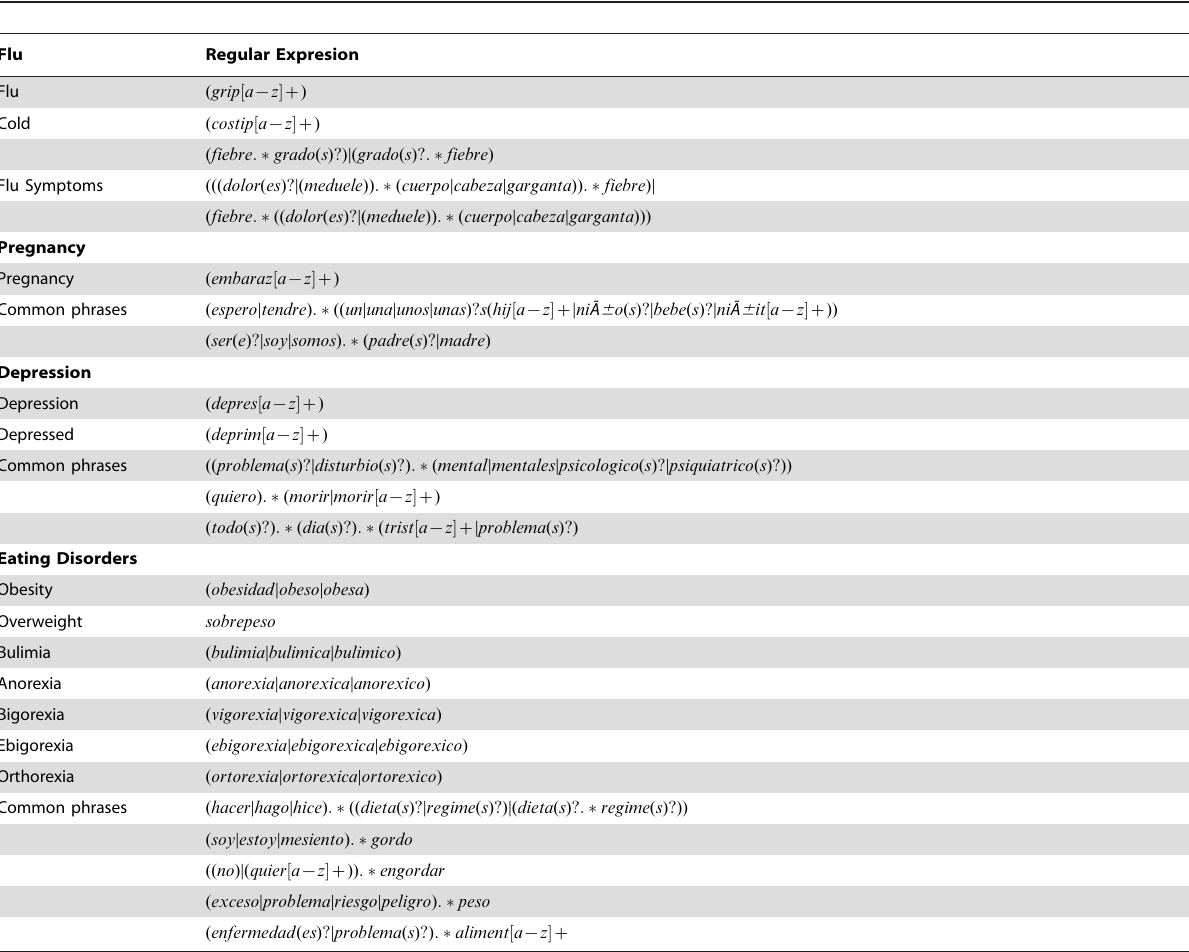
Table 1. Regular expressions for detecting health disorders in Spanish